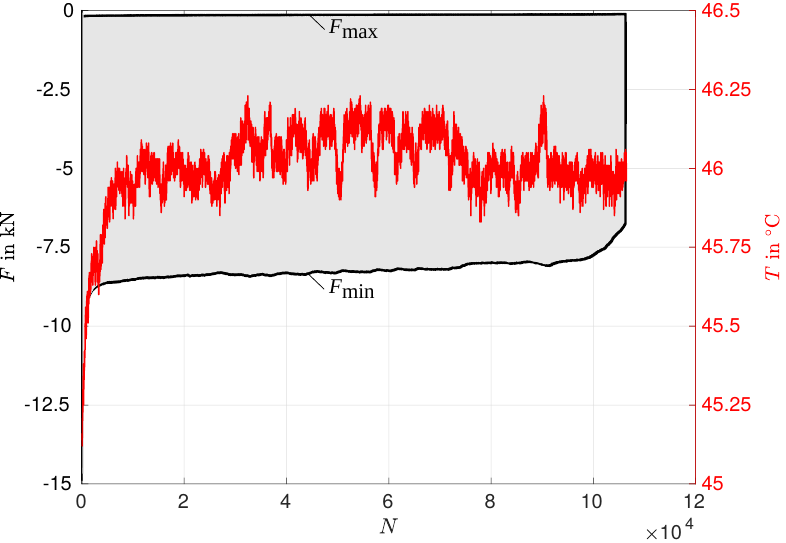
Figure 7. Force–load cycle diagram in the compression range for a filled EPDM rubber (displacement- controlled test with a mean load of u = − 15 mm and an amplitude of ˆ u = 5 mm).